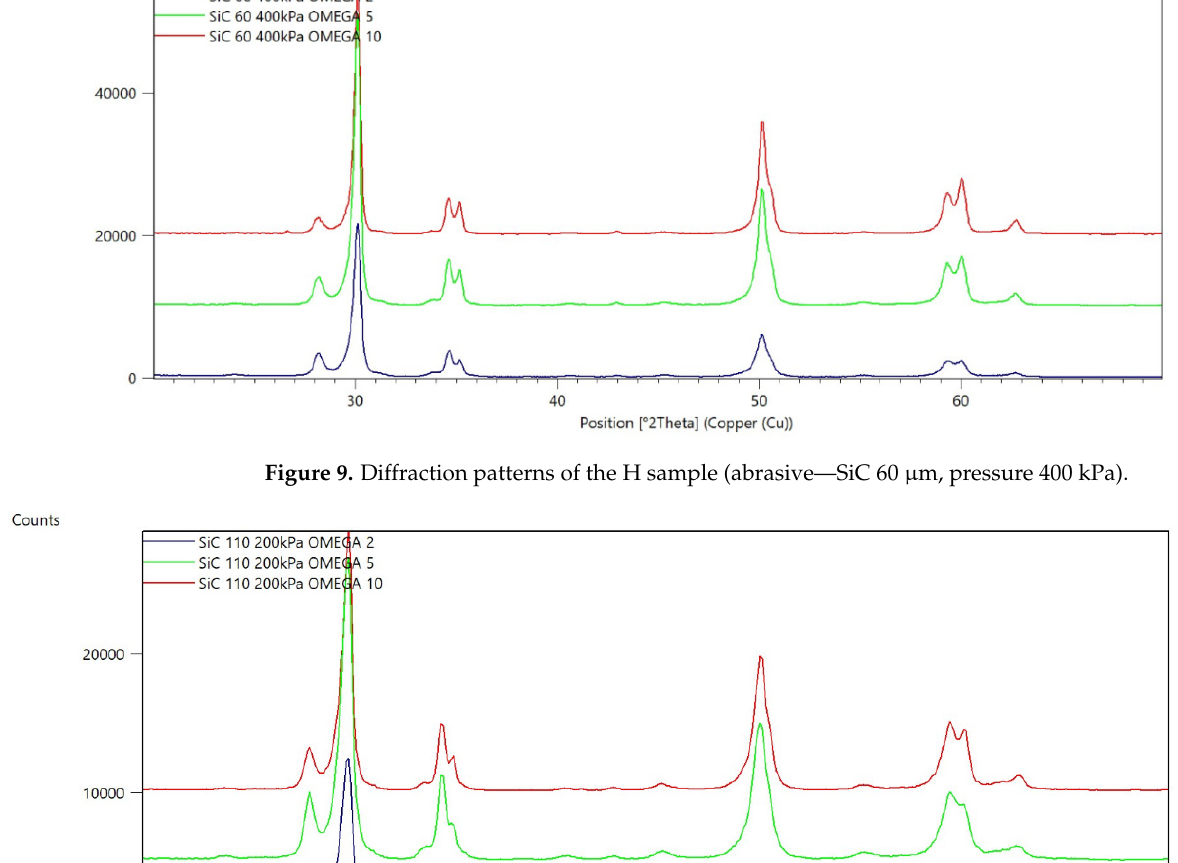
Figure 8. Diffraction patterns of the G sample (abrasive—SiC 60 μ m, pressure 200 kPa).